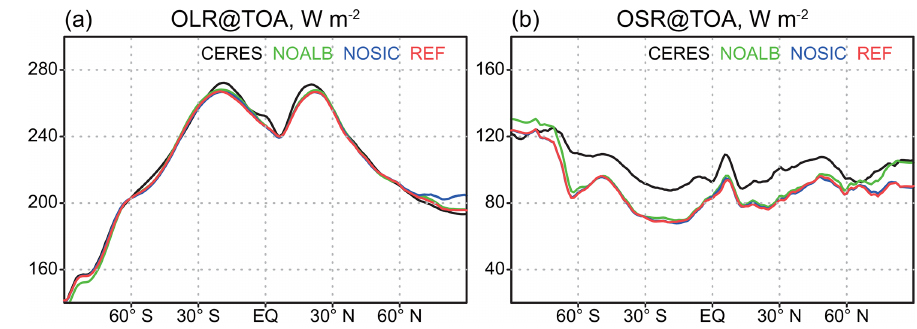
Figure 12. Same as Fig. 8 but for the NOALB (green), NOSIC (blue), and REF (red) runs by